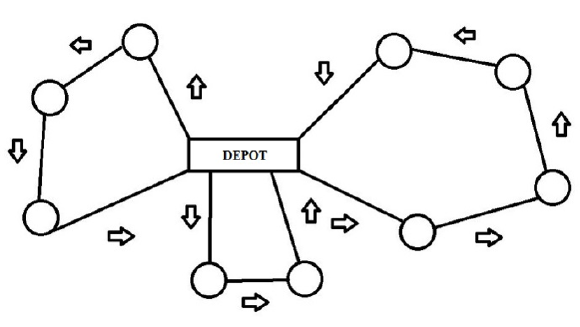
Figure 1: Sample of the multi-circuit delivery